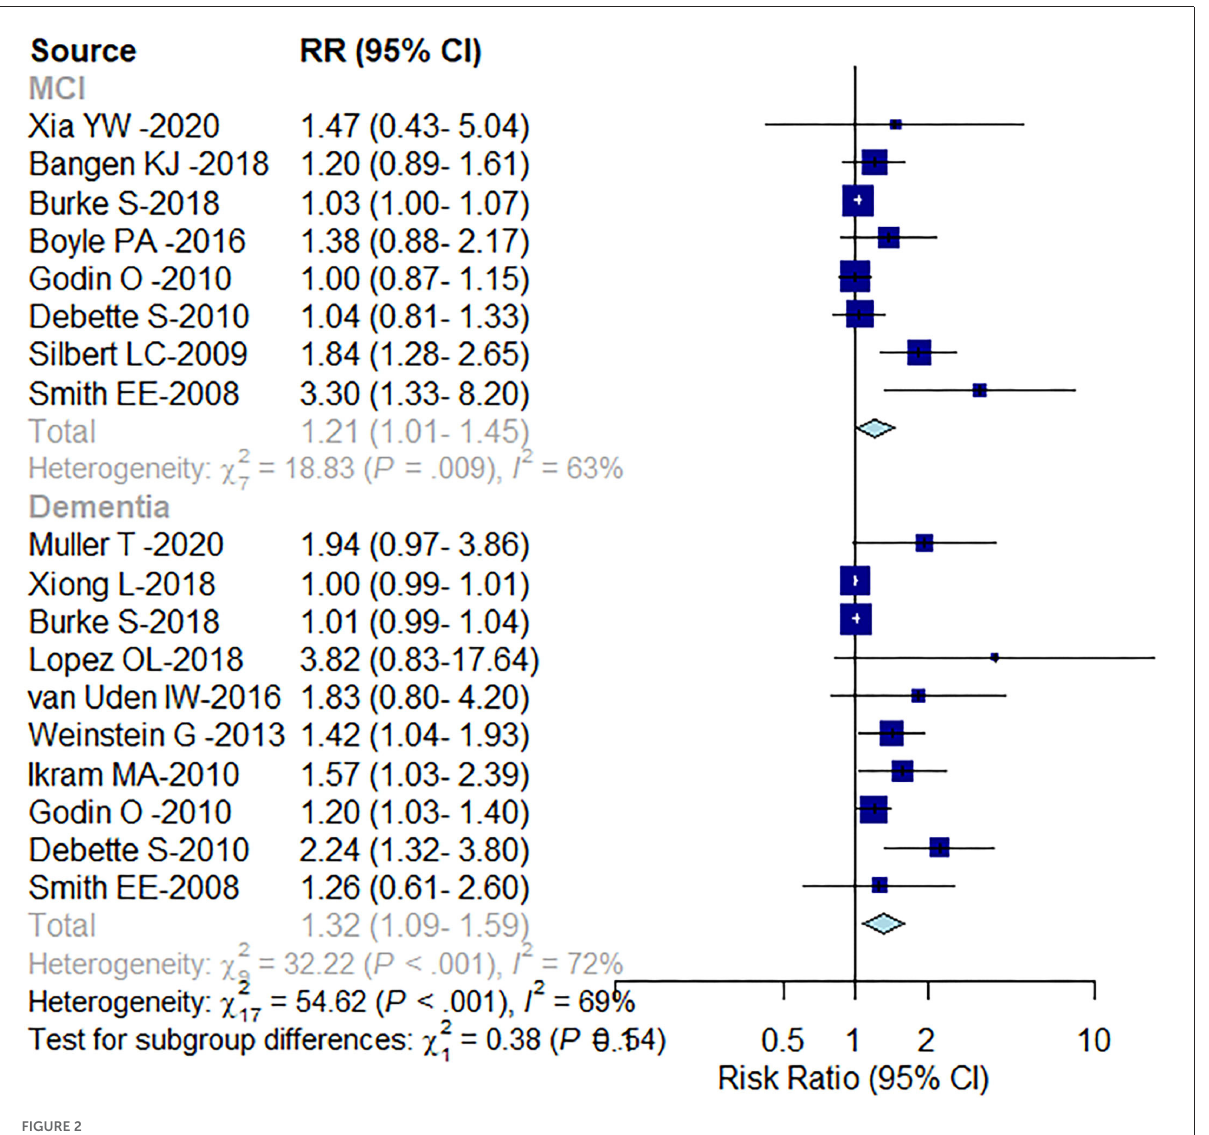
FIGURE2 Forest plot of the correlation between WMH volume and